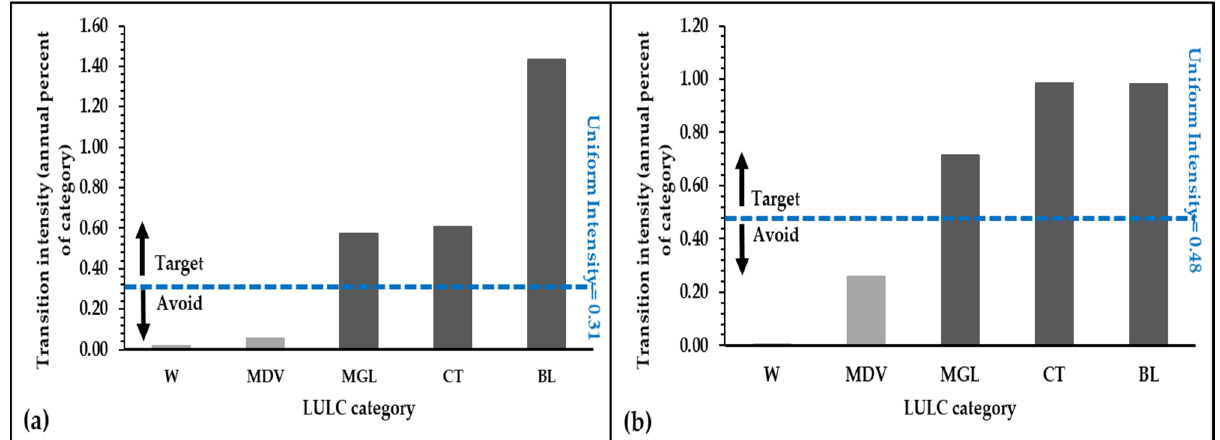
Figure 6. Transition to built-up for ( a ) 1991–2007 and ( b ) 2007–2020 for the KLCRS.